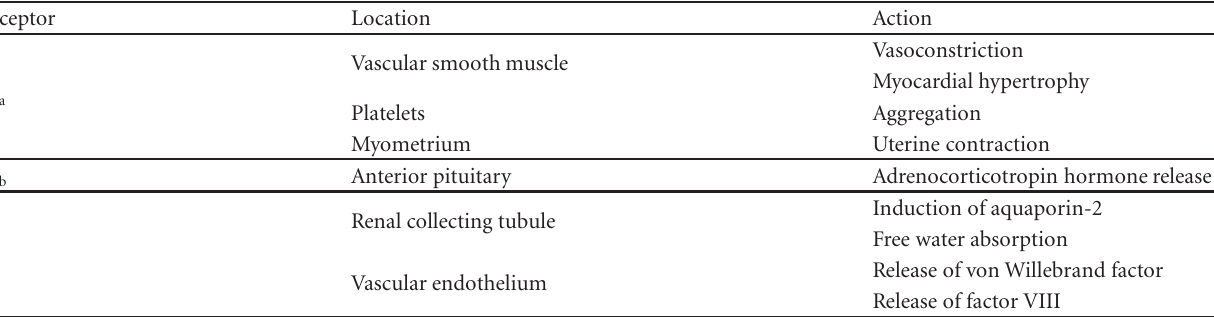
Table 1: The actions of vasopressin and its